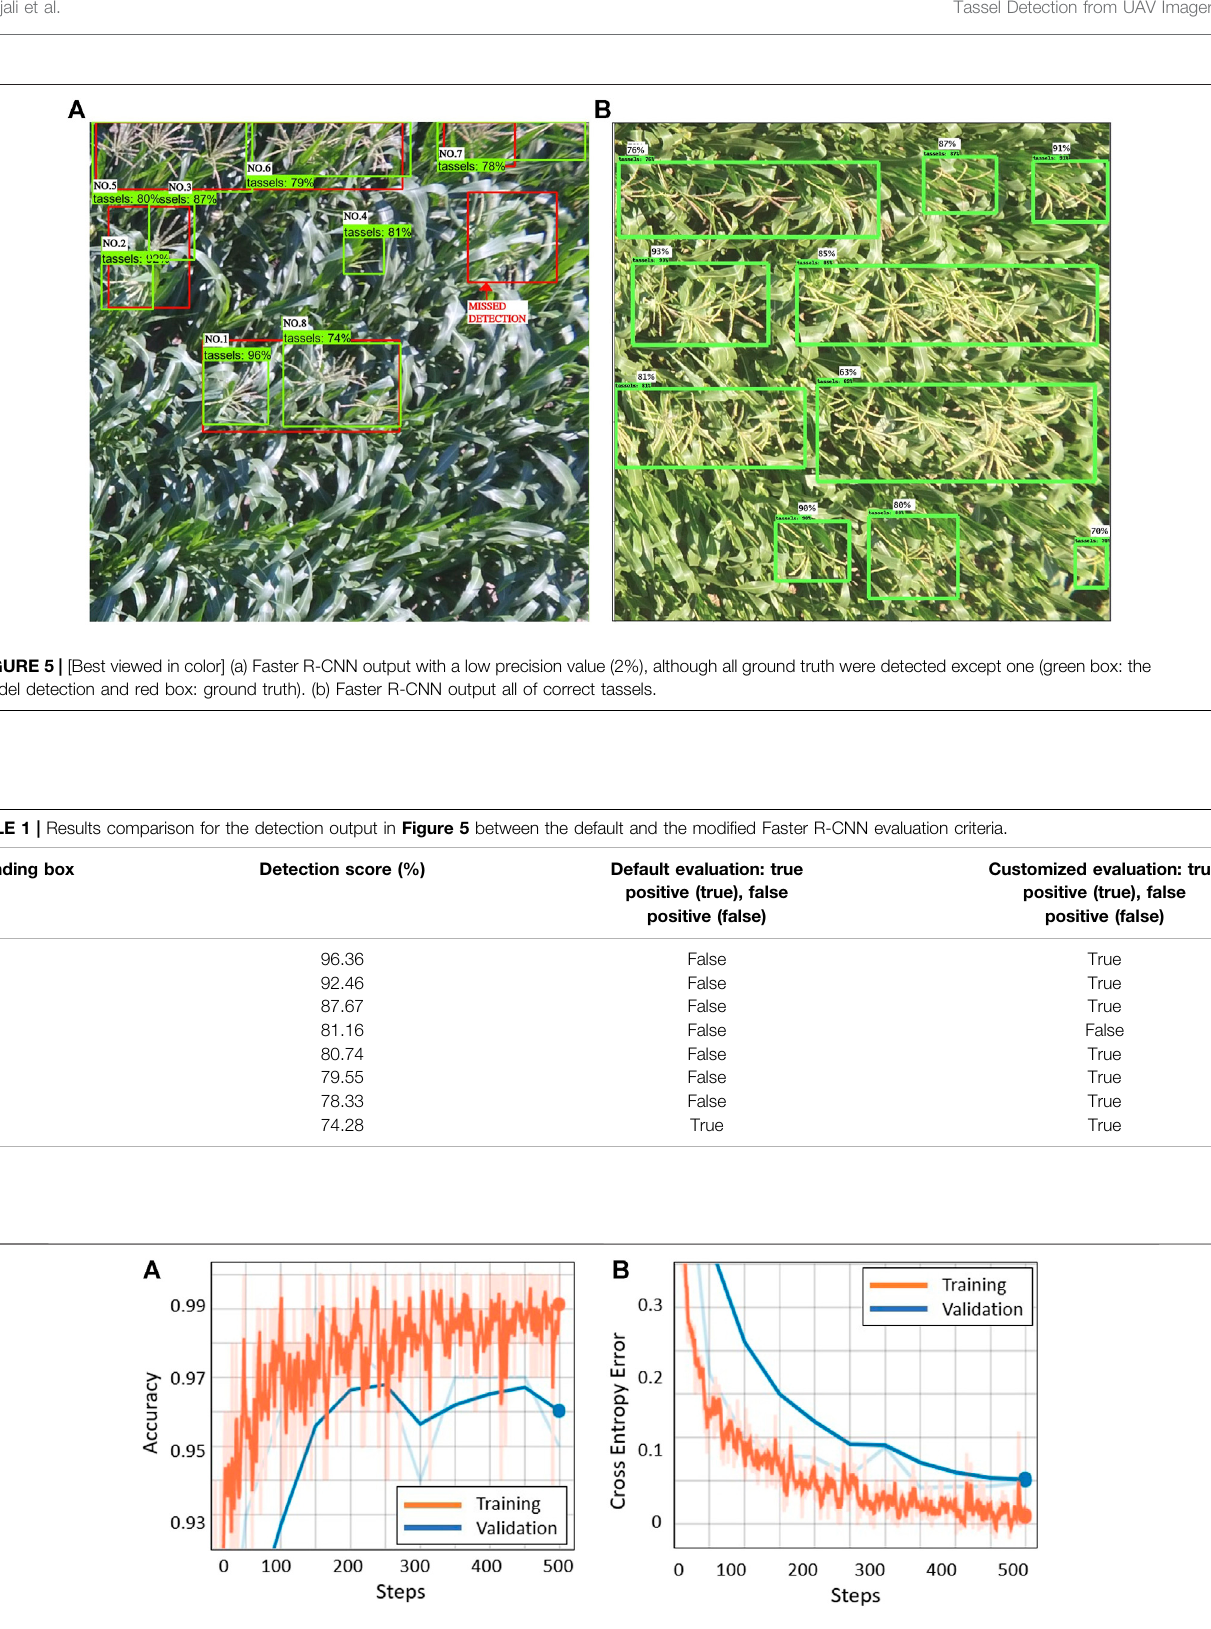
FIGURE 6 | [Best viewed in color] TD-CNN (a) Training accuracy and (b) cross entropy loss vs. number of training steps.